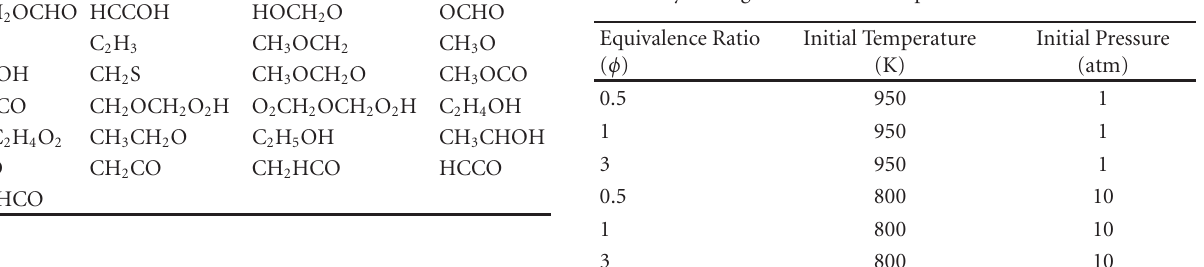
Table 1: List of QSS Species. Table 2: Targeted conditions used for development of reduced chemistry: autoignition at constant